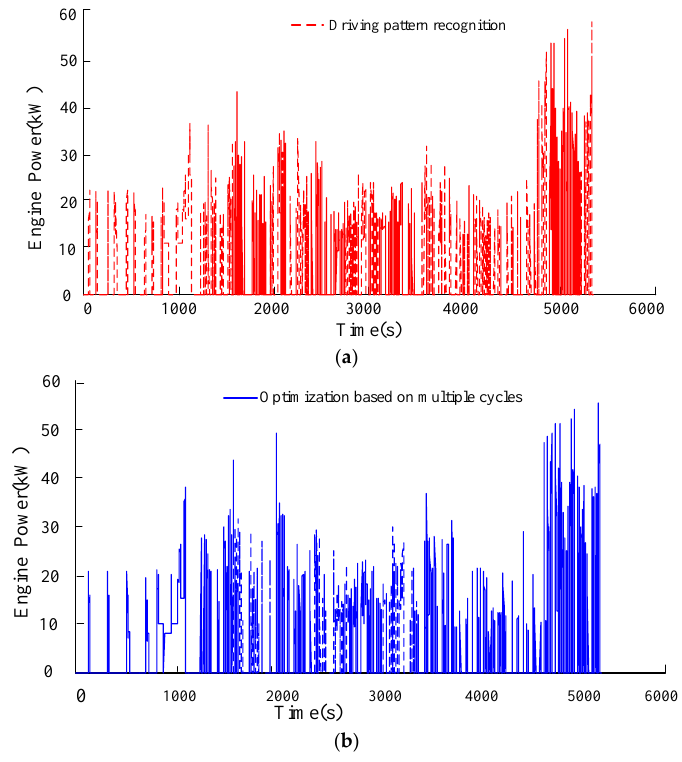
Figure 15. Engine power under the comprehensive driving cycle. ( a ) Engine power based on driving pattern recognition; ( b ) engine power based on multiple driving cycle